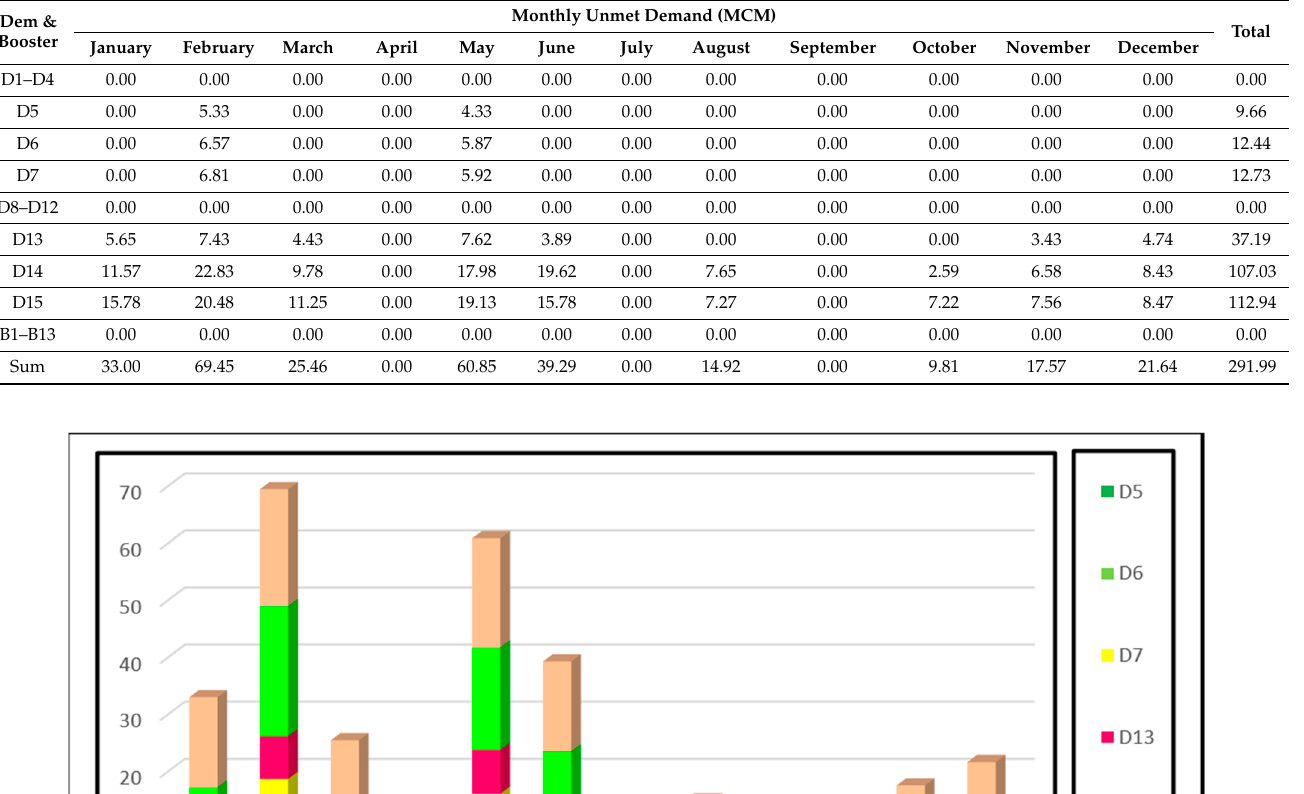
Table 11. Monthly unmet demands (MCM) of lining three sections.